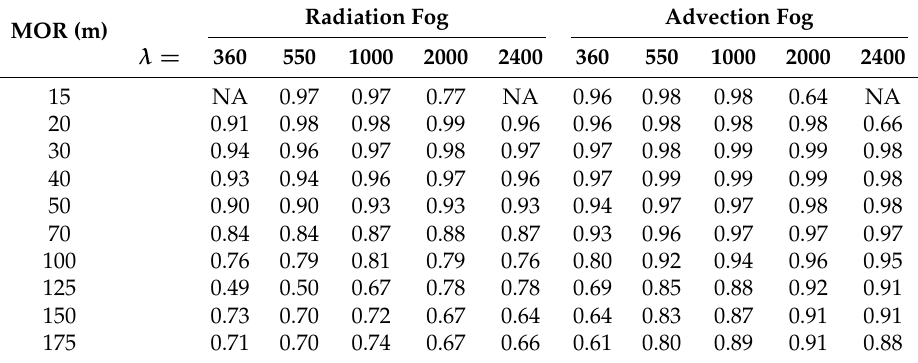
Table 2. Correlation coefficient R of the linear regression (14) for five